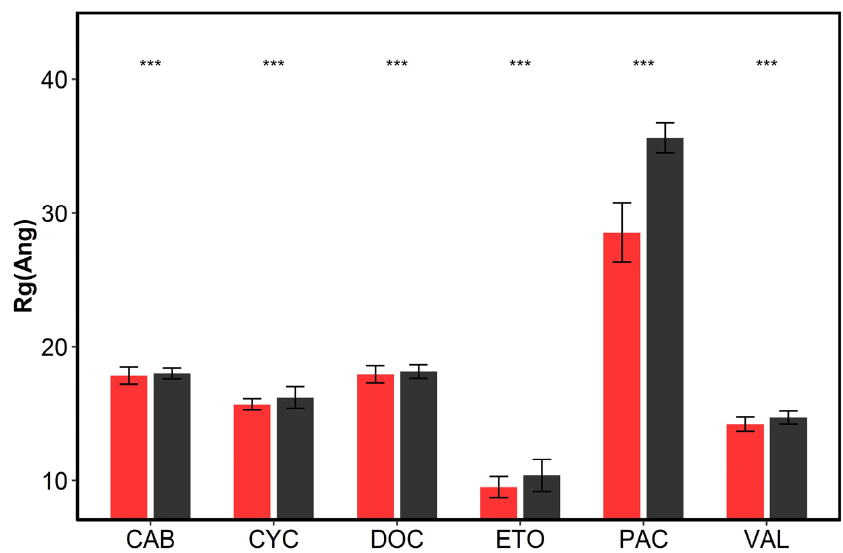
Figure 8. R g evolutions during the simulation time of ( a ) the systems without cosolvents and ( b ) the systems with cosolvents. ( A ) represents the Cyclosporine system, ( B ) represents the Docetaxel sys- tem, ( C ) represents the Etoposide system, ( D ) represents the Paclitaxel system, ( E ) represents the Valrubicin system, and ( F ) represents the Cabazitaxel system.